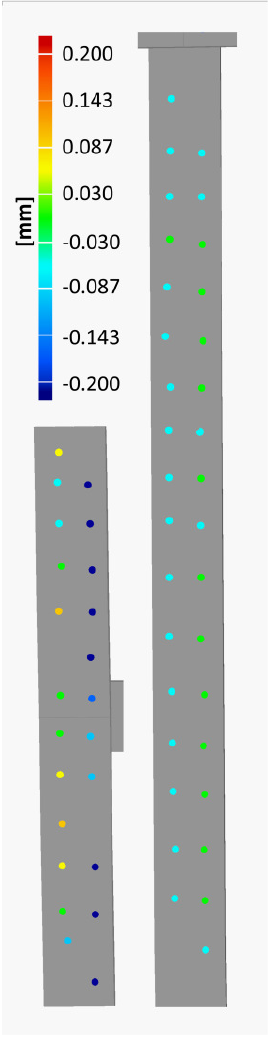
Figure 5. comparison between the determined (deformed) shape and the targeted points on the beam